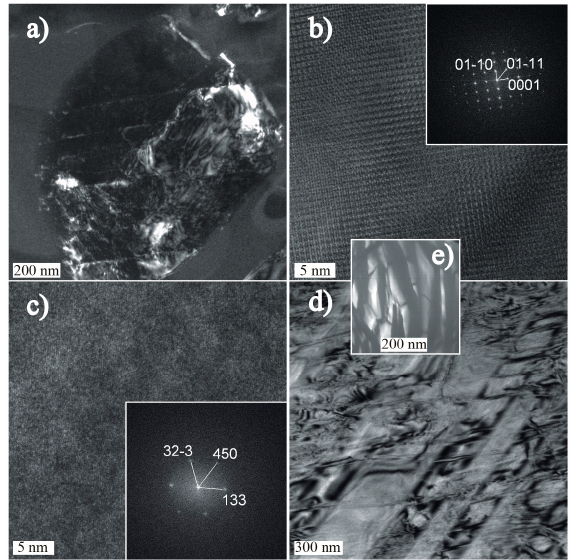
Figure 7. Transmission Electron Microscope (TEM) photomicrographs of mineral associations in the shergottite cracks: ( a ) Cl-apatite; ( b ) lattice fringe image and the corresponding diffraction pattern (FFT) of Cl-apatite; ( c ) Zr-Ti oxide inclusions-lattice fringe image with indexed diffraction pattern; ( d ) pyroxene-rim part of the crystal; and ( e ) partly recrystallized silica-rich glass